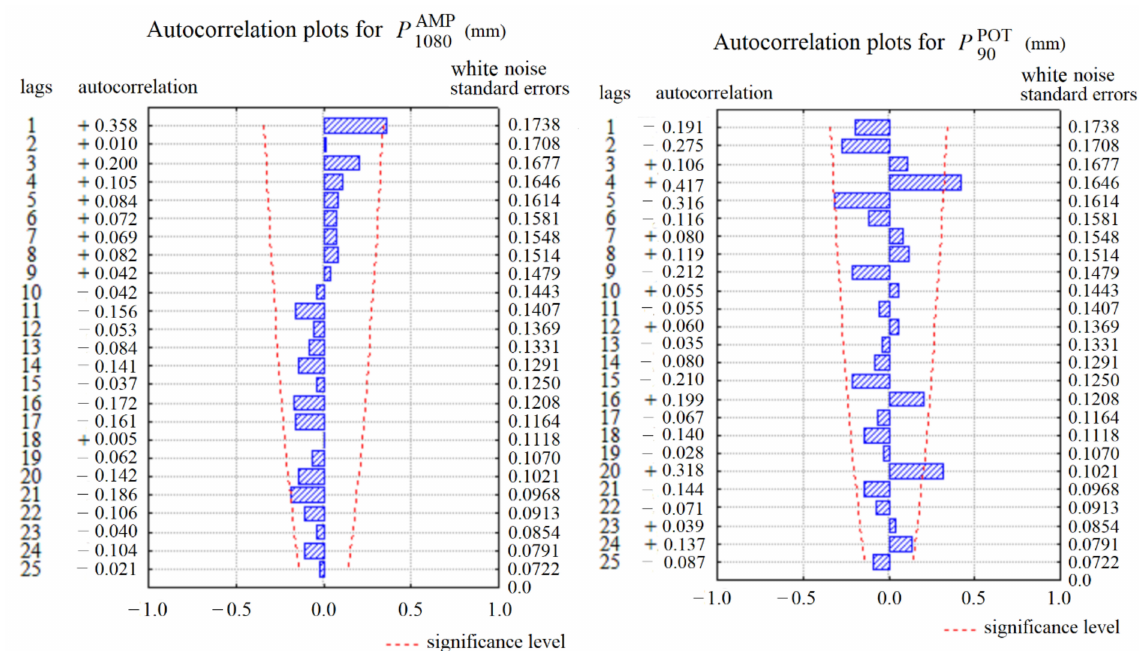
Figure 4. Autocorrelation function of random variables observed at Bialystok: P POT in a series, with indication of autocorrelation coefficients, calculated white noise (standard error), and confidence level α